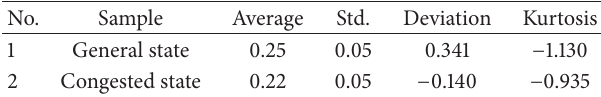
Table 6: Results of statistical analysis on the blink rate. No.